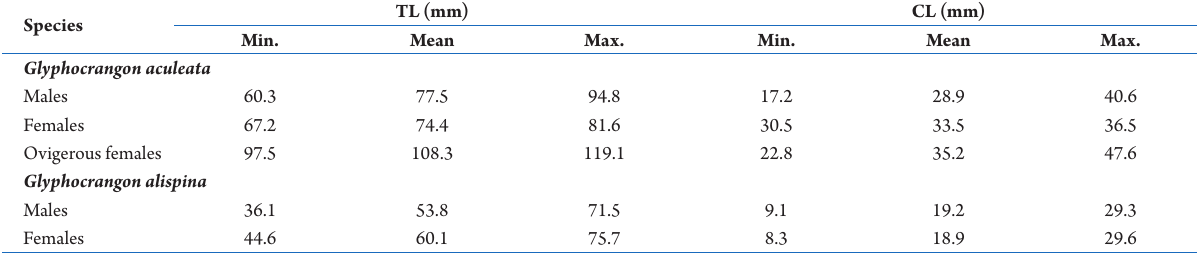
Table 2. Minimum, mean and maximum values of biometric variables (TL and CL) in males, non-ovigerous females and ovigerous females from species of the genus Glyphocrangon A. Milne-Edwards, 1881 in the Potiguar Basin, northeastern Brazil. TL (mm) CL (mm) Species Min. Mean Max.